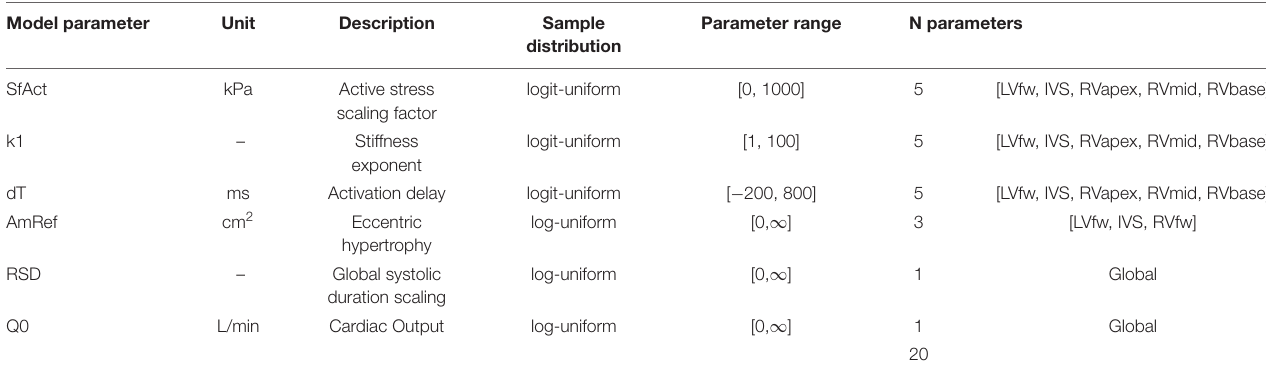
TABLE 1 | parameters included in this